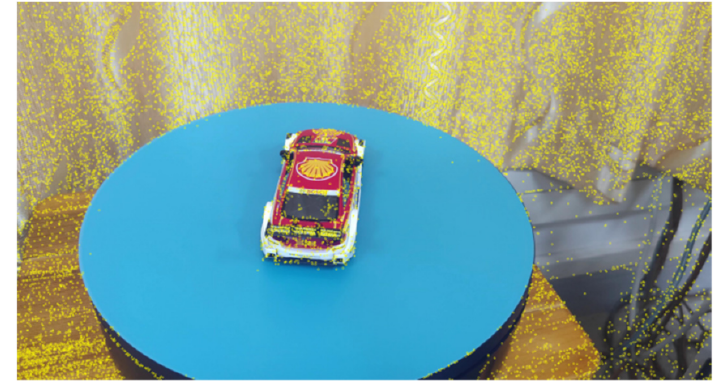
Figure 9. The features extracted from the